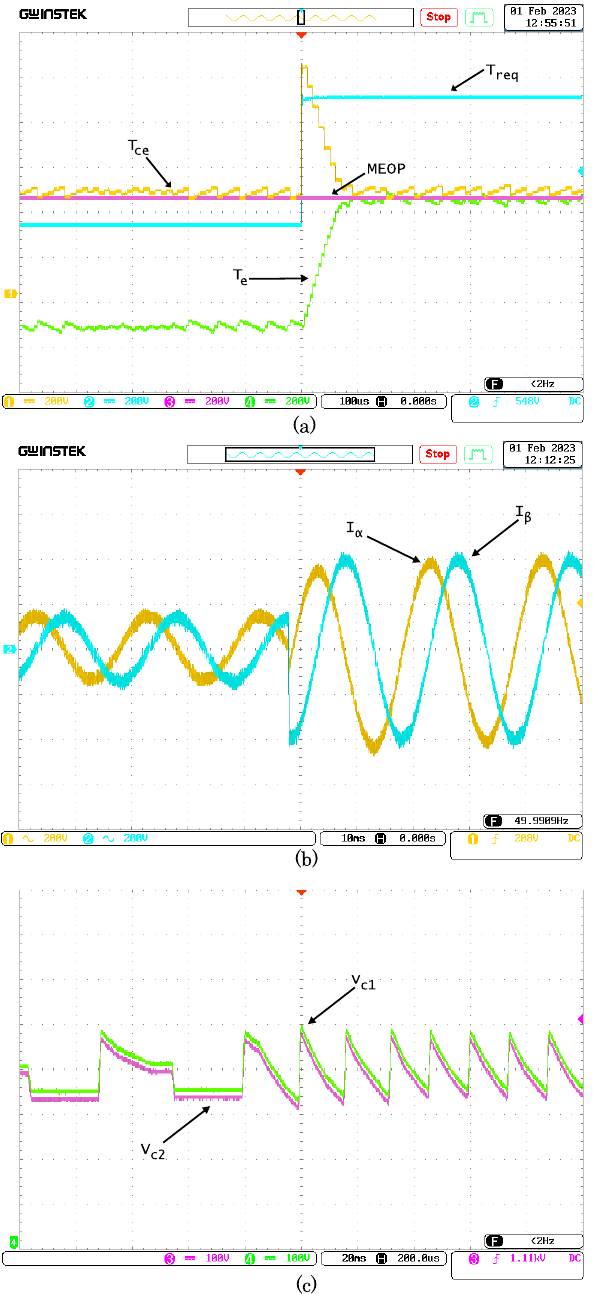
Figure 16. HIL dynamic response against step up high torque demand. ( a ) Torques at the drivetrain. ( b ) α − β Currents. ( c ) dc-Link